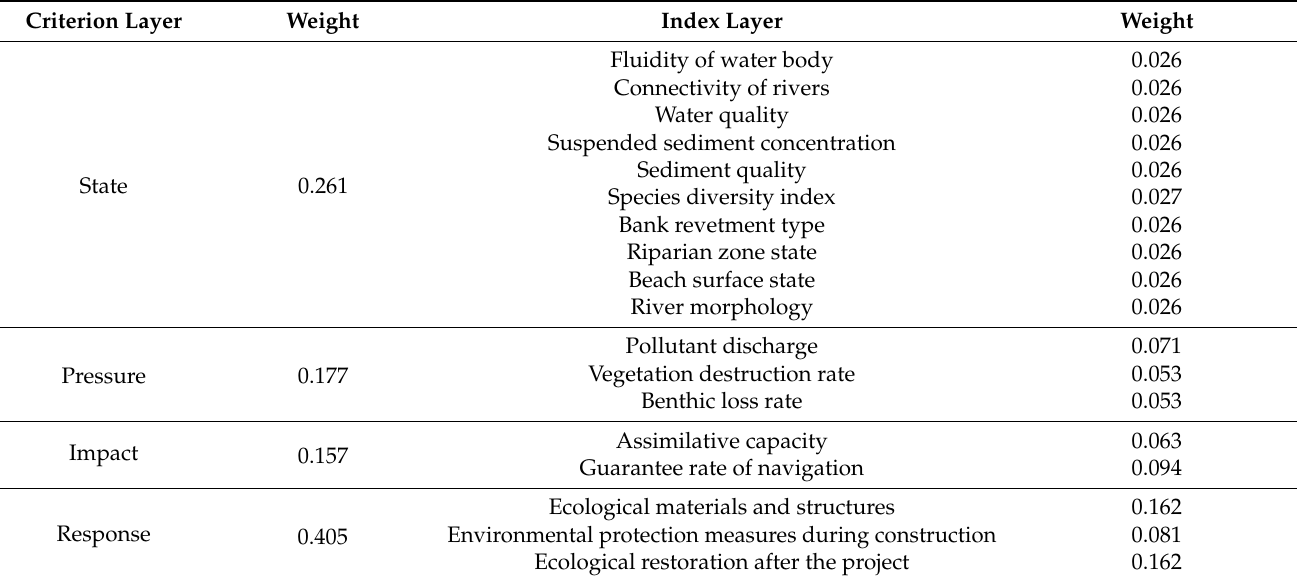
Table 4. The weight calculation results of different levels of evaluation